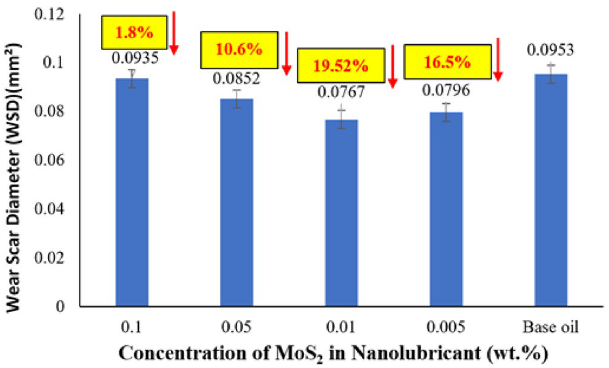
Figure 7. Average WSD profile on MoS 2 nanolubricant.